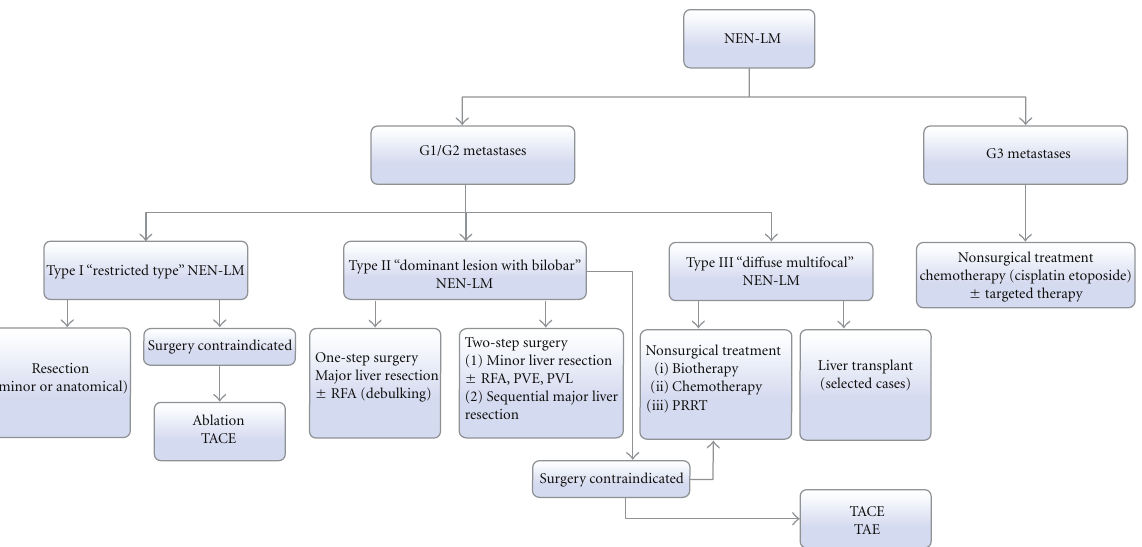
Figure 1: Suggested treatment algorithm for patients with NEN-LM. NEN: neuroendocrine neoplasm; LM: liver metastasis; RFA: radiofrequency ablation; TACE: transcatheter arterial chemoembolization; TAE: transcatheter arterial embolization; PVE: portal vein embolization; PVL: portal vein